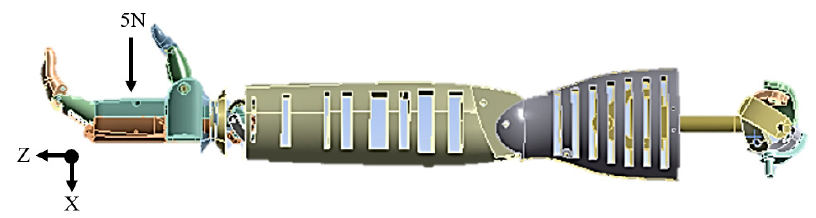
Figure 4. Application of the average load to the “X” axis.